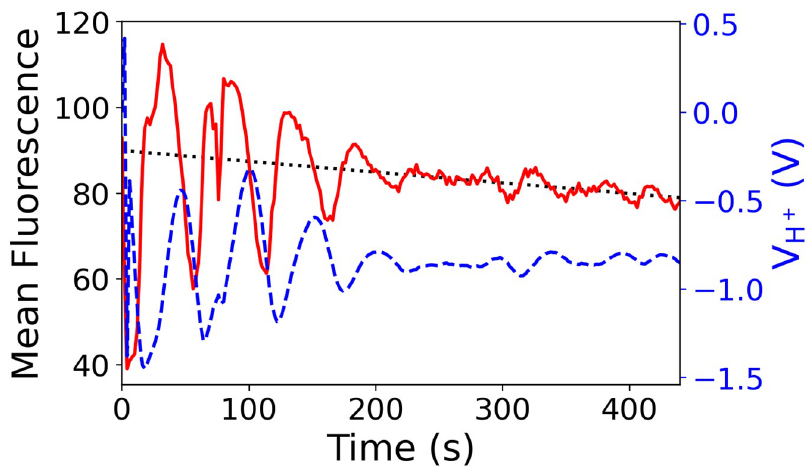
Fig 7. Close-loop control black line: Target; red line: Fluoresce respond; and blue: Controller output.